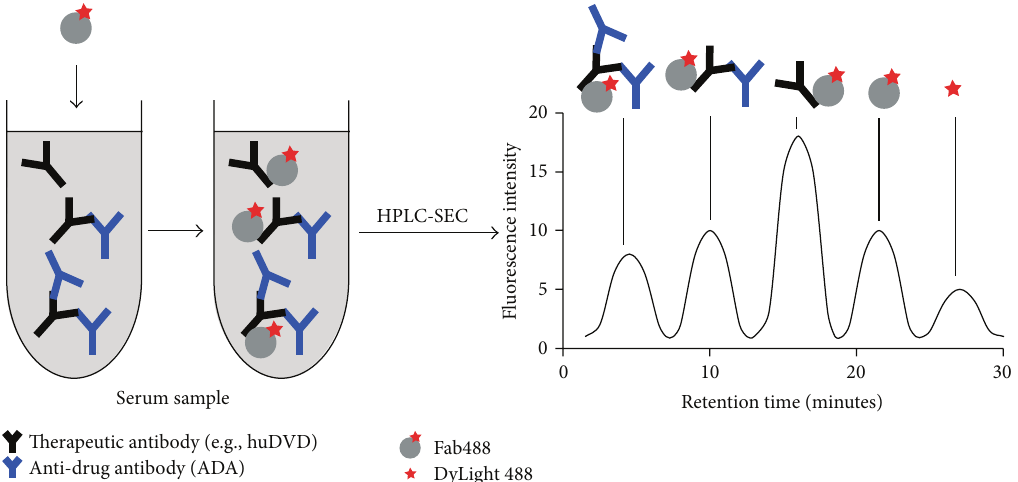
Figure 1: Principle of SEC assay. Fab488 is added to a serum sample. After incubation, Fab488 binds to the therapeutic mAb in the serum samples and to ADA complexes containing the therapeutic mAb (left). Formed complexes are separated by size exclusion chromatography (SEC) and the peaks quantified